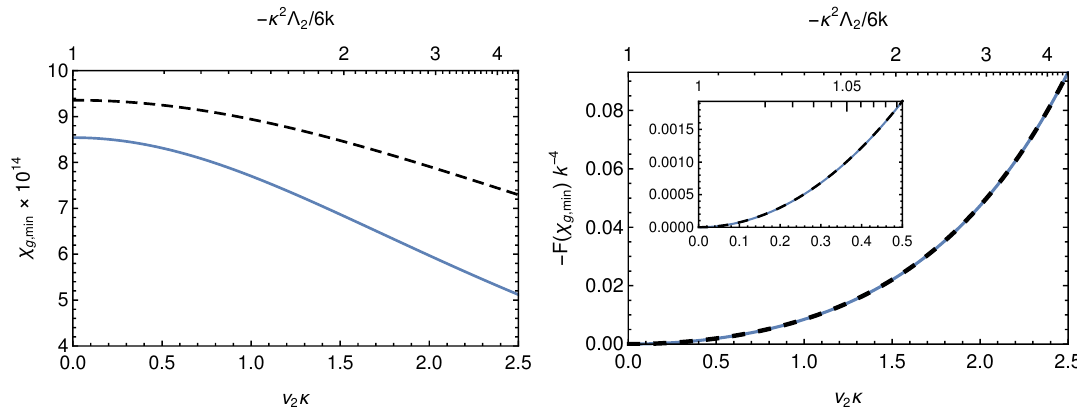
Figure 5 . Asymptotic matching approximation. The choice of parameters is (cid:20) = 0 : 5 k (cid:0) 3 = 2 , p (cid:15) = 0 : 01, (cid:3) 2 = (cid:0) 3 k cosh( 3 (cid:20)v 2 = 2) and v 1 = ( e (cid:0) 30 (cid:15) = 4) v 2 . Then, k = 1 : 72 (cid:2) 10 15 TeV (2.27). On (cid:20) 2 the left, the value of (cid:31) g; min , and on the right, (cid:0) F ( (cid:31) g; min ) = ( V e(cid:11) (0) (cid:0) V e(cid:11) ( (cid:31) g; min )) =(cid:31) 4 function of v 2 (cid:20) and (cid:0) (cid:20) 2 (cid:3) 2 = 6 k . The blue line is the exact calculation. The black dashed line are values obtained with (4.6) and